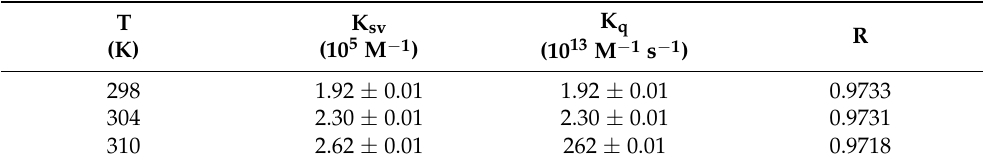
Figure 7. Fluorescence spectra of α - glucosidase in the presence of increasing concentrations of α - mangostin (0.05 – 1.5 µM) at 298, 304, and 310 K ( A , B and C ) and the Stern – Volmer plot of fluorescence quenching ( D ). Table 3. The quenching constant (K sv ) and the bimolecular quenching constant (Kq) of α -mangostin with α -glucosidase at different temperatures.